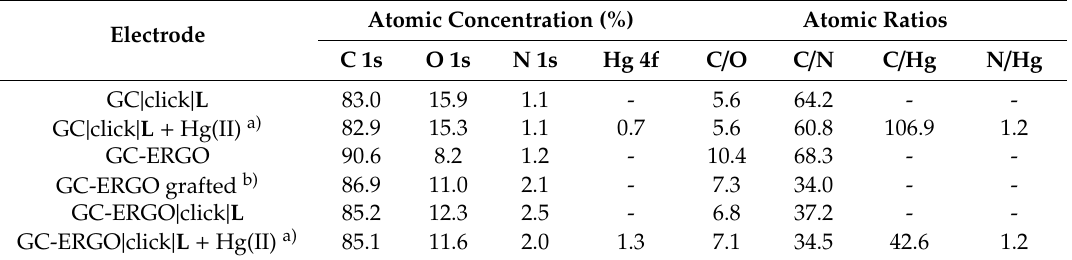
Figure 5. XPS survey spectra of GC and GC-ERGO electrodes after various modification steps: ( A ) GC | click | L ; ( B ) GC | click | L treated in a Hg(II) solution; ( C ) GC-ERGO; ( D ) GC-ERGO grafted with phenylethynyl groups; ( E ) GC-ERGO | click | L ; ( F ) GC-ERGO | click | L treated in a Hg(II) solution. Table 2. Atomic composition of the electrode surface after various modification